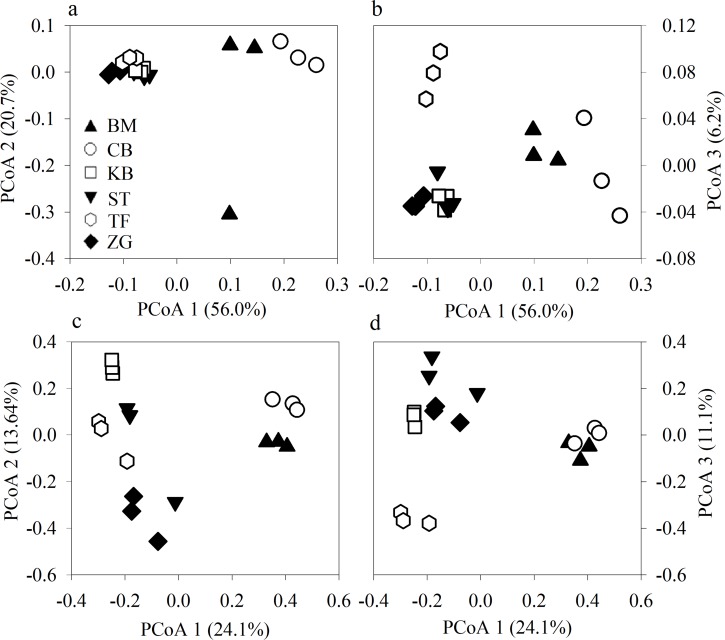
Principal coordinate analysis (PCoA) of soil microbial communities.Soil bacterial (a, b) and fungal (c, d) communities in six turfgrass systems (BM, bermudagrass; CB, creeping bentgrass; KB, Kentucky bluegrass; TF, tall fescue; ST, St. Augustinegrass; ZG, zoysiagrass). Cool- and warm-season turfgrass systems are represented by empty and filled symbols, respectively.